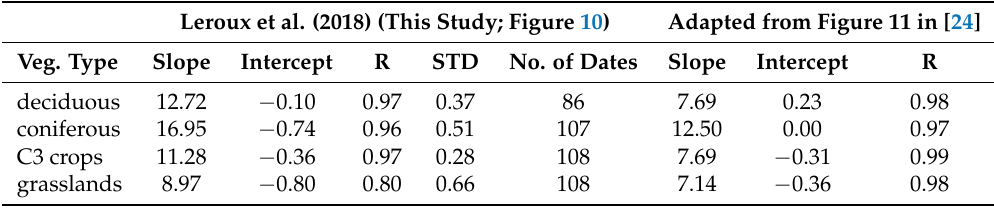
Table 2. Linear regression between averaged monthly values of observed SIF and analyzed GPP over the pixels covered by at least 50% of one vegetation type: deciduous forests, coniferous forests, C3 crops, grasslands. Slope (in g(C).sr.nm.mW − 1 · day − 1 ), intercept (in g(C) · m − 2 · day − 1 ), correlation